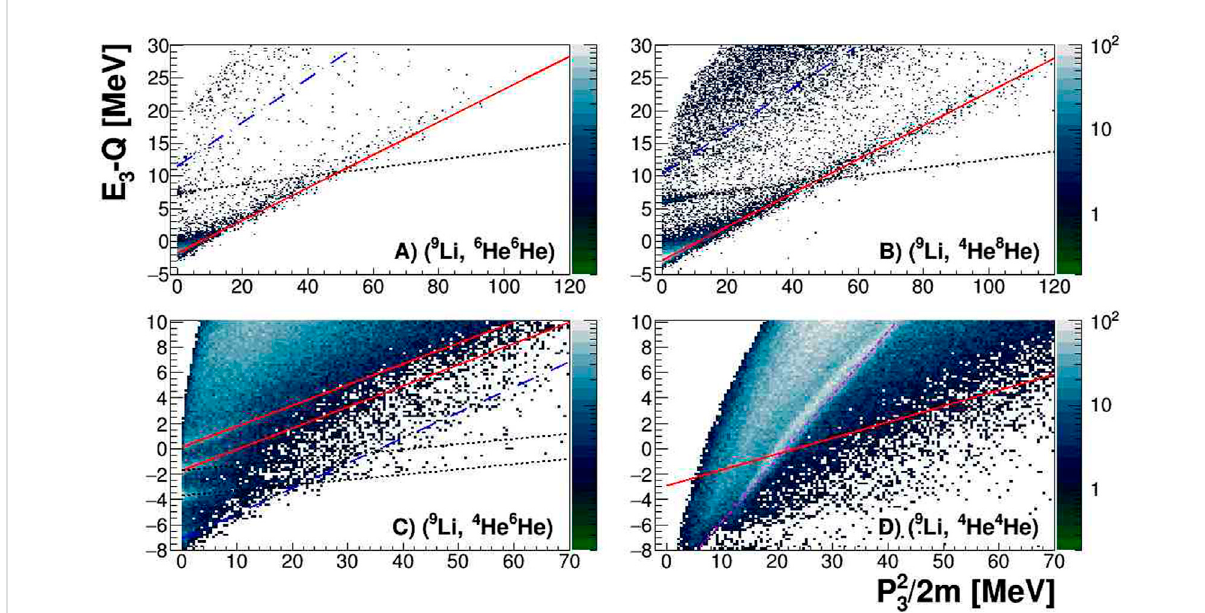
FIGURE 3 Examples ofthecorrelationplotsfortheidenti fi cationofeventsoriginatingfromvariousreactionexitchannels:Catania plotsreconstructed for the coincident detection of reaction product pairs relevant for the 12 Be excited states. The spectra (A,C) correspond to the data for the 6 He + 6 He decay of the 12 Be excited states, i.e. reaction (2) with Q value of 2.253 MeV. The spectra (B,D) are for the 4 He + 8 He decay and reaction (1) with Q = 3.402 MeV. In all the cases, reaction products are detected as dT = 3 events. Red lines mark loci associated with the reaction on the 7 Li, blue dashedlinesonthe 6 Li,andblackdottedlinesonthe 19 F.AdditionalredandblacklinesinplotCcorrespondtoundetected 6 Heinits fi rstexcitedstate at 1.8 MeV for reaction on 7 Li, and to undetected 18 O in its fi rst excited state at 1.99 MeV for reaction on 19 F, respectively. On plot D, intense locus of the events marked with purple line corresponds to the reaction on hydrogen content of the